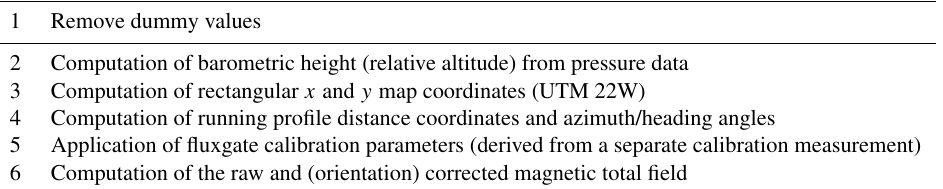
Table A1. Processing steps of UAS fixed-wing